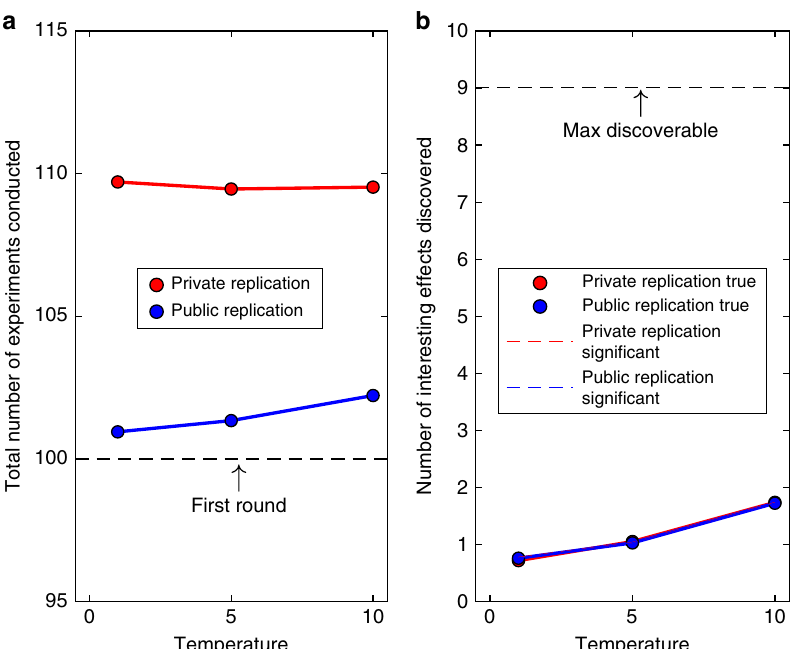
Fig. 5 Scienti fi c achievements and costs for discovery-oriented research, using Bayesian analysis. a shows the cost (total number of experiments conducted) to generate the knowledge (true effects discovered) shown in b . Temperature refers to the temperature of the logistic decision function (Methods section). Successful replications are identi fi ed by dashed lines in b . Successful replications that are also true (i.e., the null hypothesis was actually false) are identi fi ed by plotting symbols and solid lines.